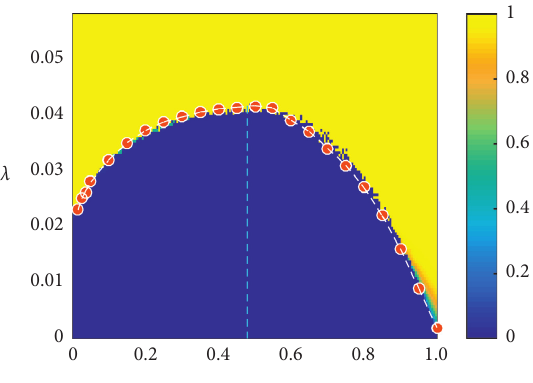
Figure 2: The phase diagram in the parameter plane ( α − λ ) on a scale-free network. Colors encode the value of ρ obtained from Monte Carlo simulations. Red circles connected by dotted lines represent theoretical predictions of epidemic threshold λ c . The blue dotted line . Data are obtained by averaging 50 Monte Carlo simulations for each point in the grid 200 × indicates the location of optimal value α opt